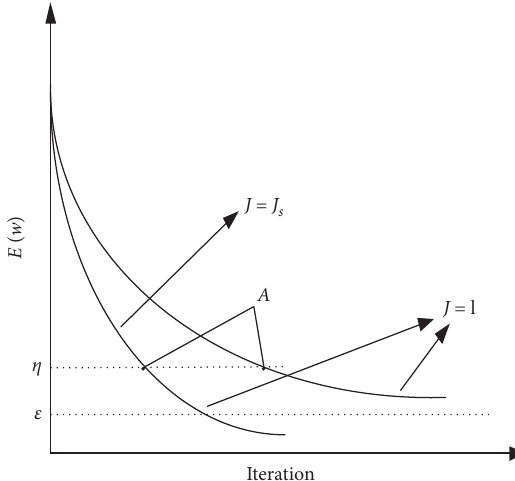
Figure 5: The relationship between the number of iterations and the training error under the asynchronous long update strategy.